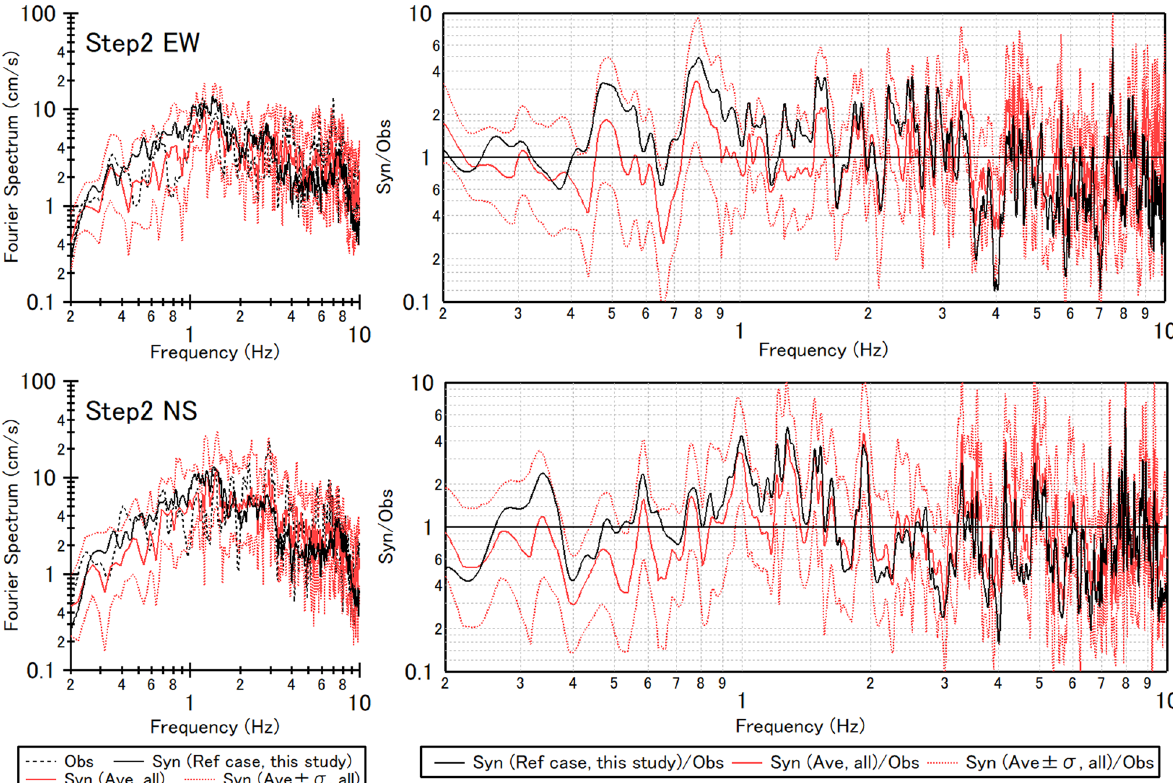
Fig. 15 Comparisons of the predictions in this study and those by blind prediction participants for the earthquake of 2016/04/16 3:03 (M w 5.5). (Left) Black dashed and solid lines indicate the observed spectra and the synthetic spectra of the reference case, respectively. Red solid and dashed lines indicate the average and average σ spectra of all participants, respectively. (Right) Black and red lines indicate the ratio of the lines of same ± type in the left panel to the observed